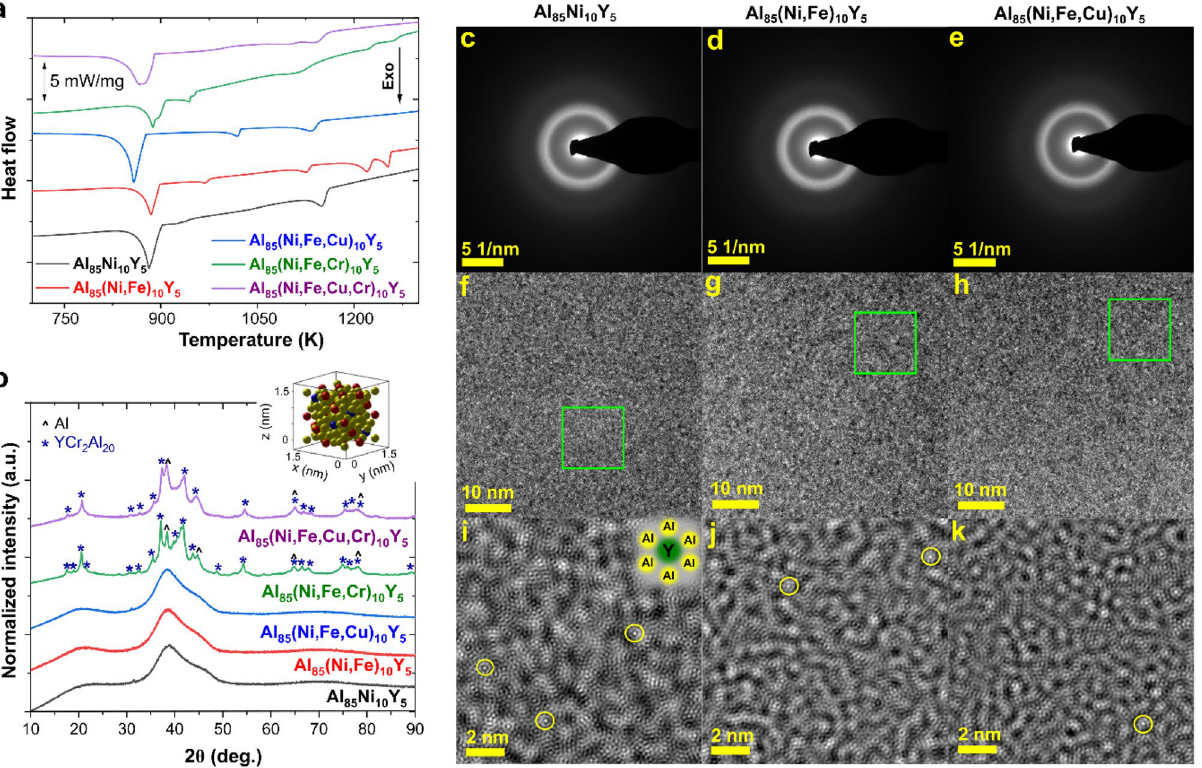
Figure 1. ( a ) DTA curves collected for crystalline alloys; ( b ) XRD patterns of amorphous and amorphous- crystalline ribbons with marked peaks corresponding to the Al and YCr 2 Al 20 phases (insets shows the unit cell of the YCr 2 Al 20 phase—Y, Cr, and Al were marked as blue, red and yellow balls, respectively); SAED patterns of Al amorphous alloys for Al 85 Ni 10 Y 5 ( f and i ), Al 85 (Ni, Fe) 10 Y 5 ( g and j ), and Al 85 (Ni, Fe, Cu) 10 Y 5 ( h and k )—inset in ( i ) represent the identified atomic clusters, which were marked using yellow circles in figures ( i, j ).